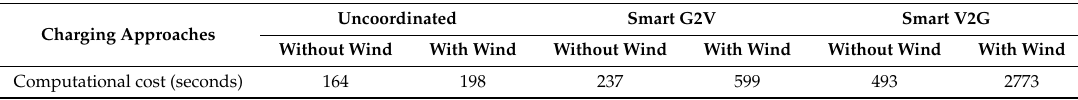
Table 7. The Computational Cost for Di ff erent